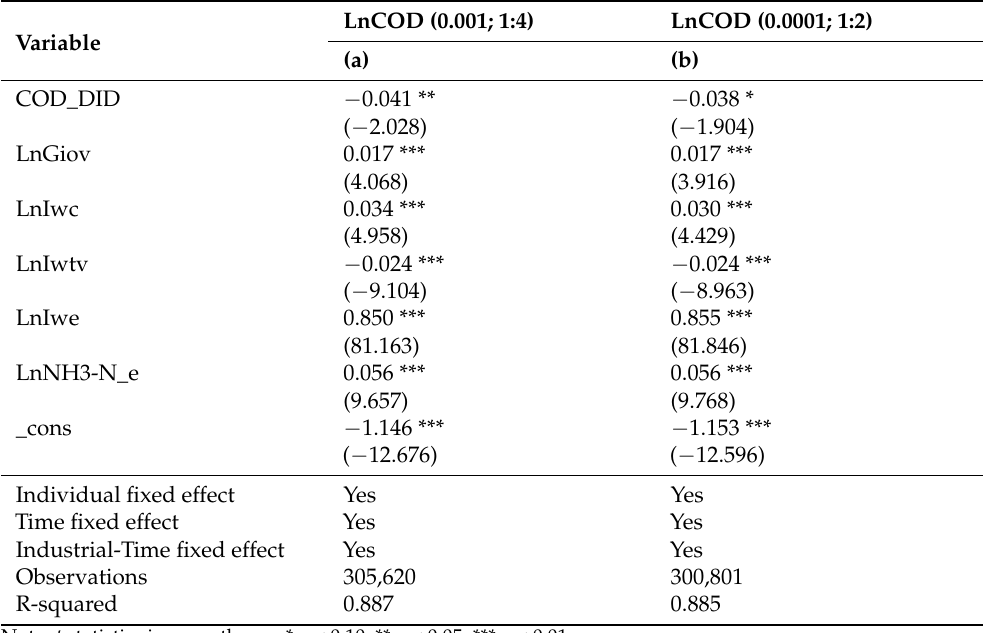
Table 4. Regression results of PSM-DID